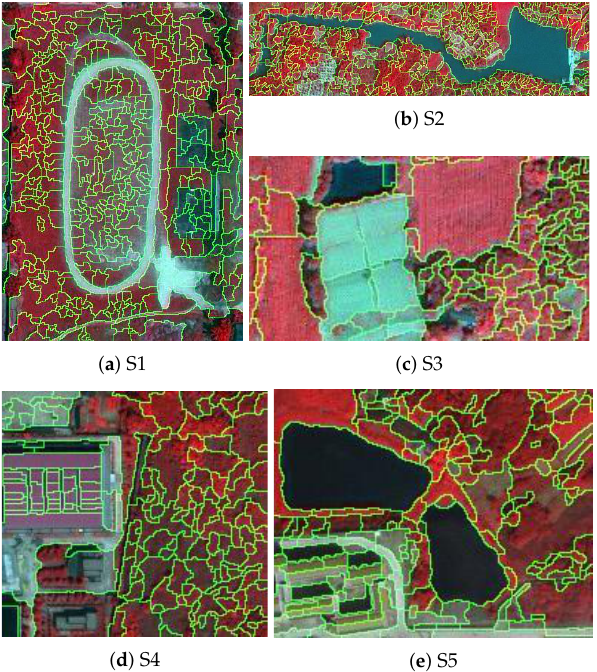
Figure 8. Watershed segmentation by Hill-Marker with the parameter of minsize being